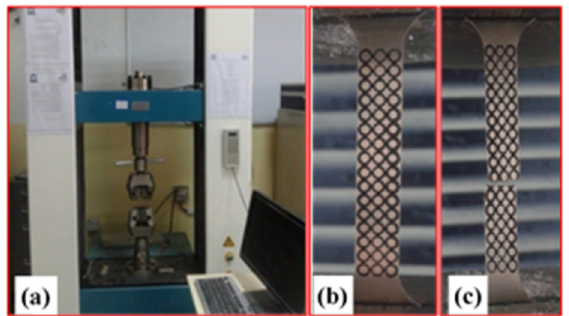
Fig. 3. (a) LARYEE machine (b) Dogbone sample before the test (c) Dogbone sample after the test.